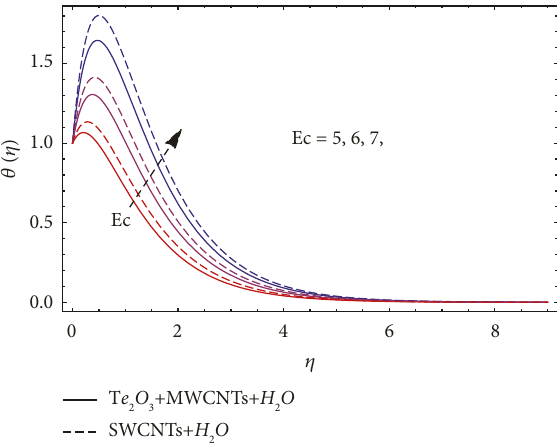
Figure 9: Influence of hall parameter on velocity profile in y direction.